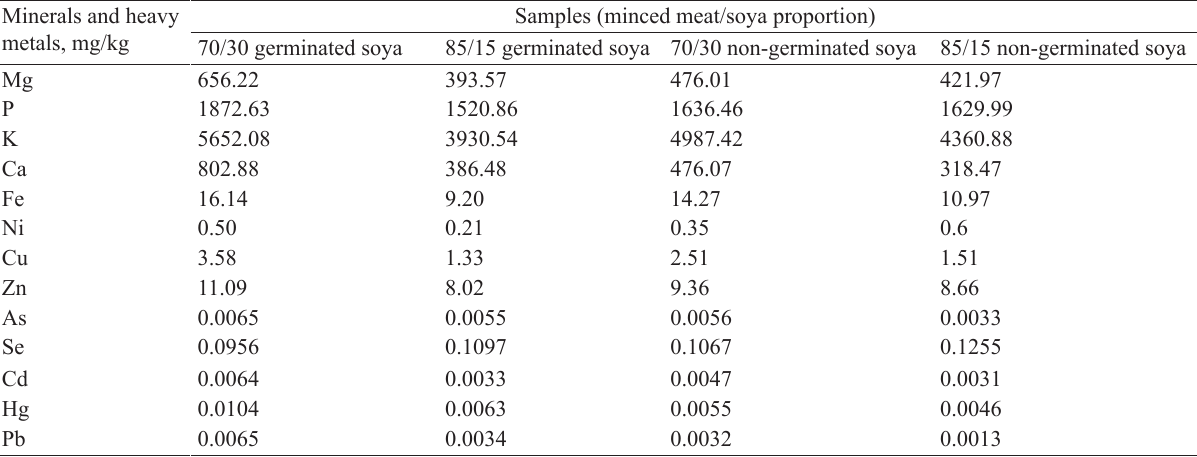
Samples (minced meat/soya